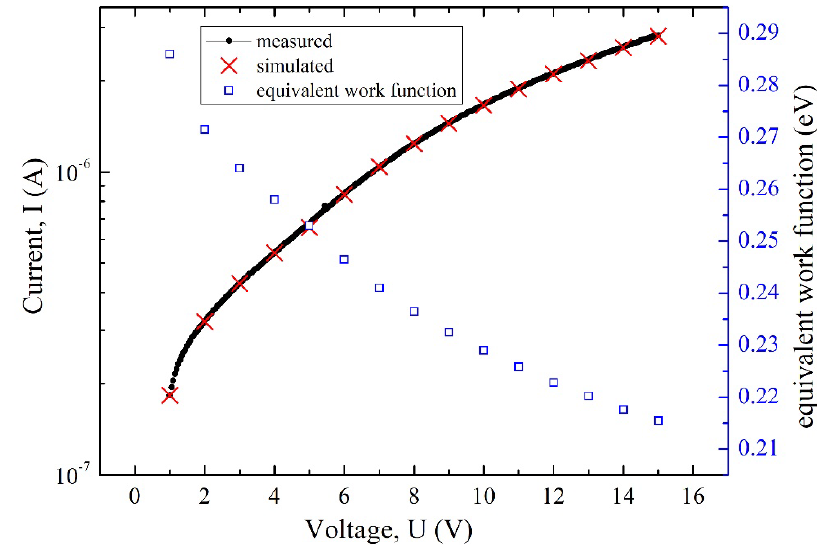
Figure 3. Equivalent work function of cathode under different voltage bias.